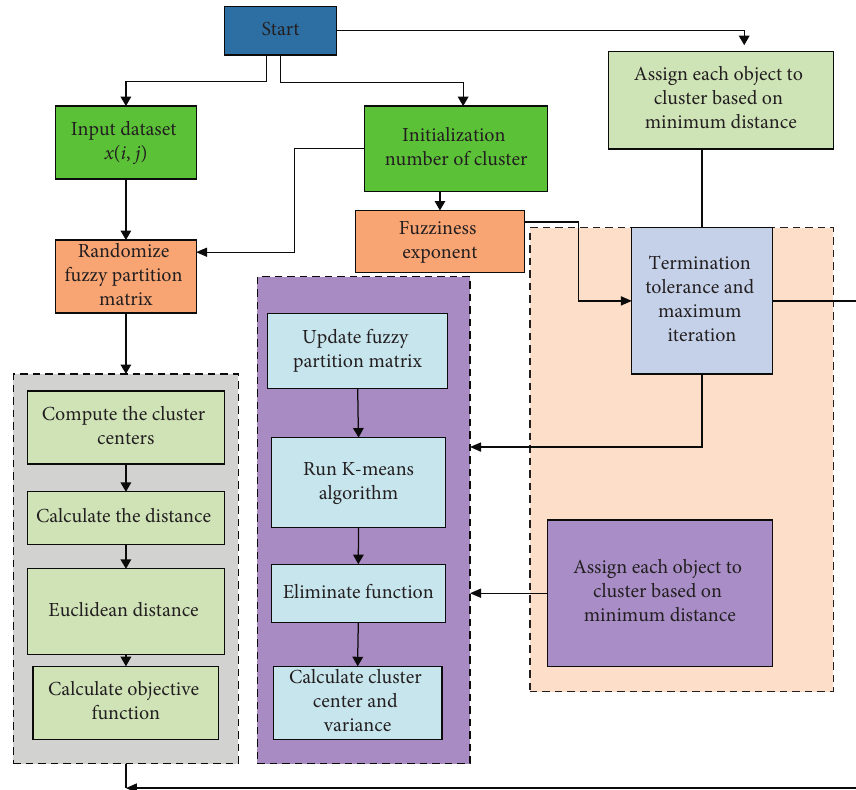
Figure 2: Parallel fuzzy clustering algorithm flow chart.